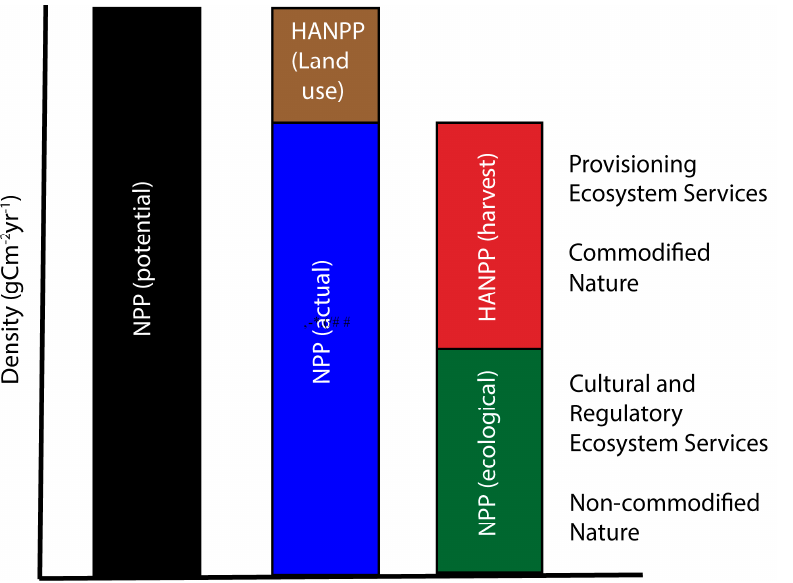
Figure 1. Conceptual definition of HANPP, partitioning NPP into a harvested component and NPP (ecological).